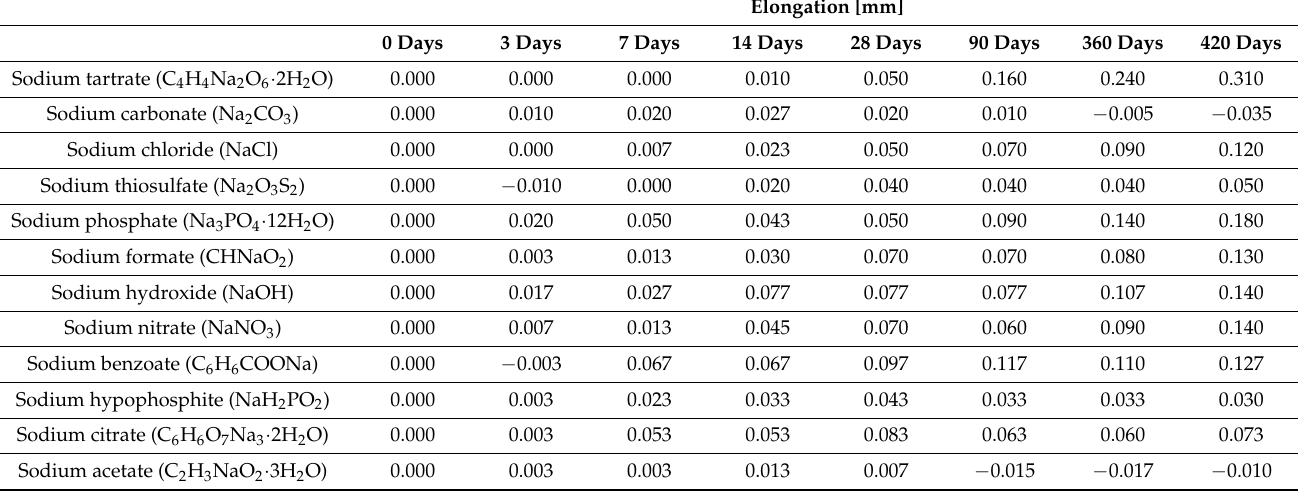
Table 3. Changes in the linear dimensions of paste